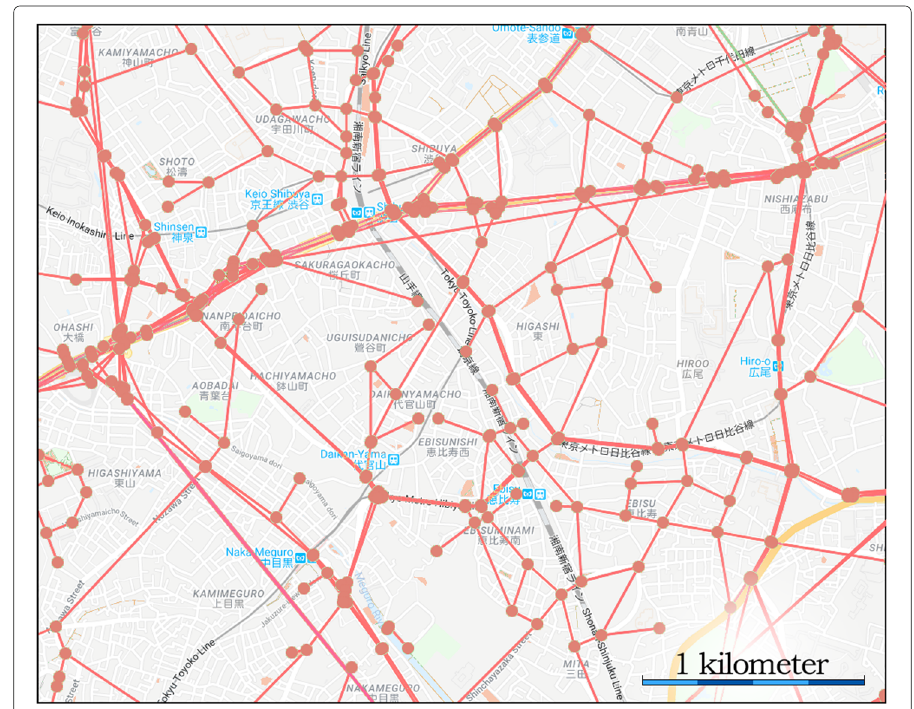
Fig. 4 A sample of the road network superimposed on the map. Although small local roads were excluded from the road network, connections to the hex network fill in the gaps and provide dense coverage. The diagram demonstrates both the high frequency of apparent dead-ends (leaf nodes) and our elimination of non-intersection nodes. Map data ©2019 Google